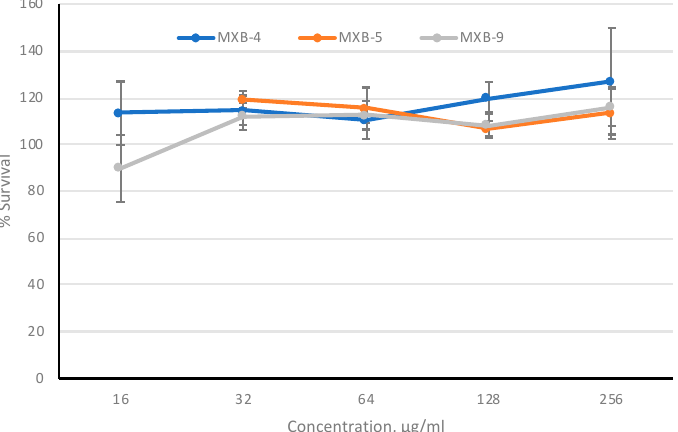
Figure 6. In vitro toxicity of peptoids. Peptoids were incubated on the apical surface of cultured EpiAirway cells ( n = 3 wells per concentration) for 3 h. Cell viability was quantified by MTT assay and are shown as mean percent survival +/ − SD. Results shown are representative of two independent replicate experiments.